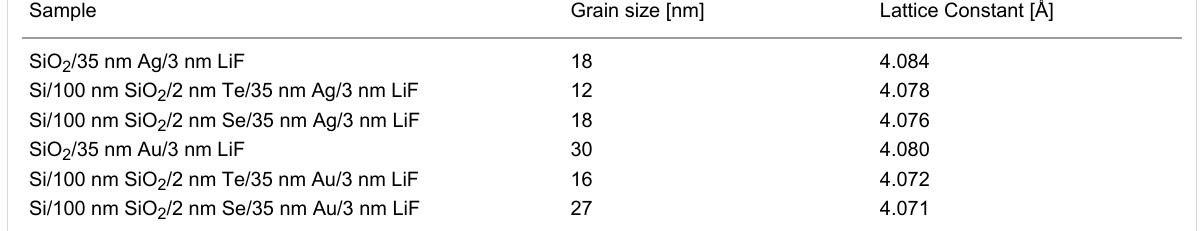
Table 1: XRD results. XRD-determined average grain size and lattice constant for 35 nm-thick Ag and Au layers deposited with 2 nm-thick Te or Se sublayers. For comparison, the values for films deposited directly on glass substrates are also presented from [12,28]. Sample